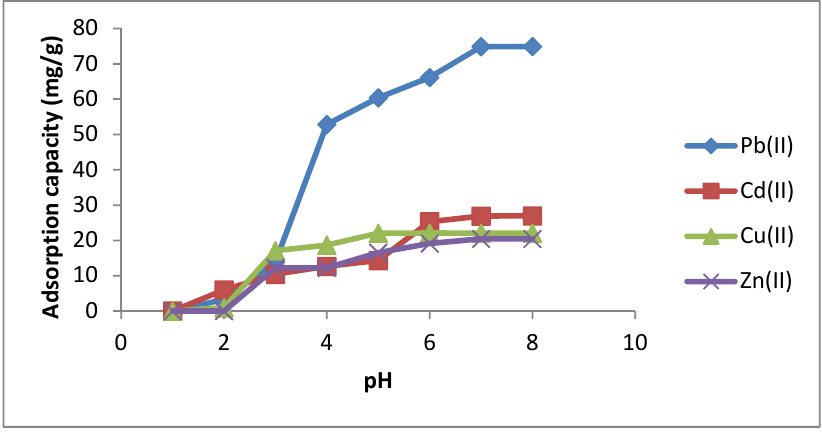
Figure 6. Adsorption kinetics of Pb(II), Cd(II), Cu(II) and Zn(II) on SiNP.